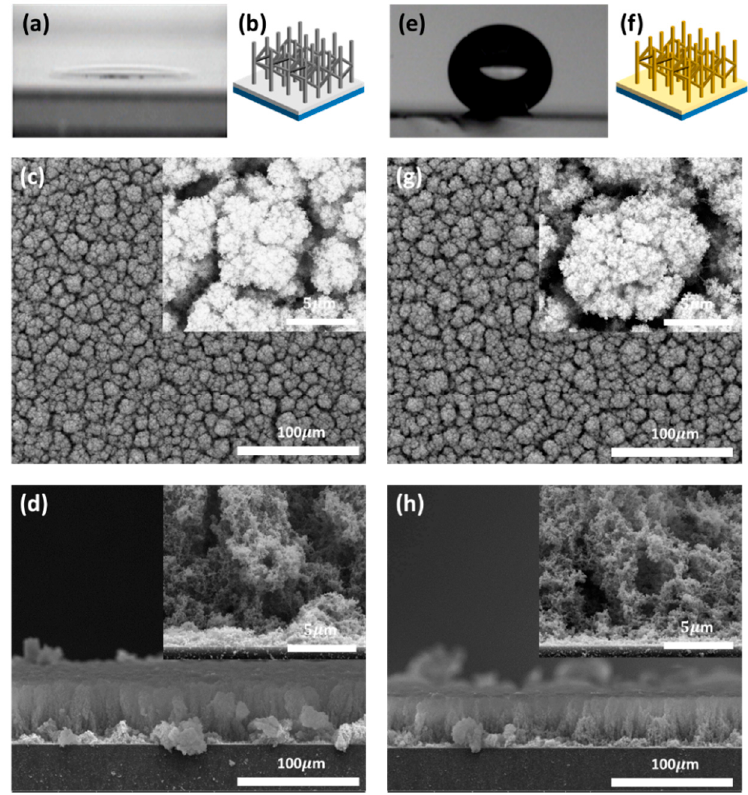
Figure 1. Water contact angle and FE-SEM images of the developed porous SnO 2 film before and after PFOTS coating. ( a ) Water contact angle of the porous SnO 2 film. ( b ) Schematic of the grown SnO 2 film. ( c ) Top view and ( d ) cross-sectional view of the SEM image of the porous SnO 2 film. ( e ) Water contact angle of the PFOTS coated porous SnO 2 film. ( f ) Schematic of the grown PFOTS coated SnO 2 film. ( g ) Top view and ( h ) cross-sectional view of the SEM image of the PFOTS coated porous SnO 2